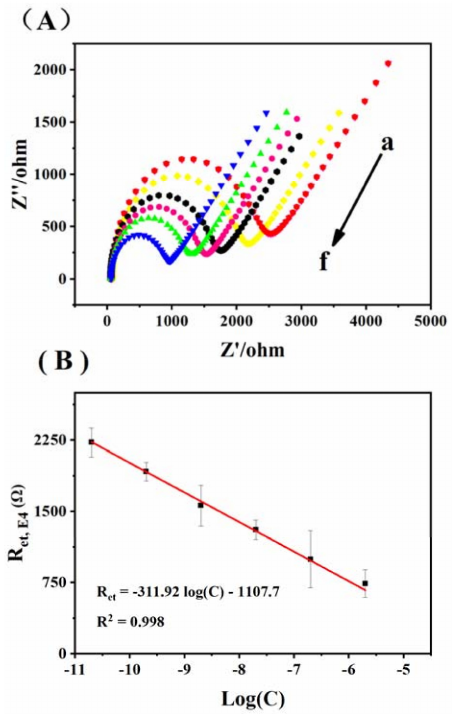
Figure 3. ( A ) Nyquist diagrams recorded at TSPP/dsDNA/MWCNTs/GCE ( E4 ) with different concentrations of target DNA: 2.0 × 10 − 11 M (a), 2.0 × 10 − 10 M (b), 2.0 × 10 − 9 M (c), 2.0 × 10 − 8 M (d), 2.0 × 10 − 7 M (e) and 2.0 × 10 − 6 M (f); ( B ) Plot of the relative changes of the impedance value R et Table 3. Comparison of some biosensors for the detection of DNA specific to genes that belong to the same family of tyrosine kinase receptor